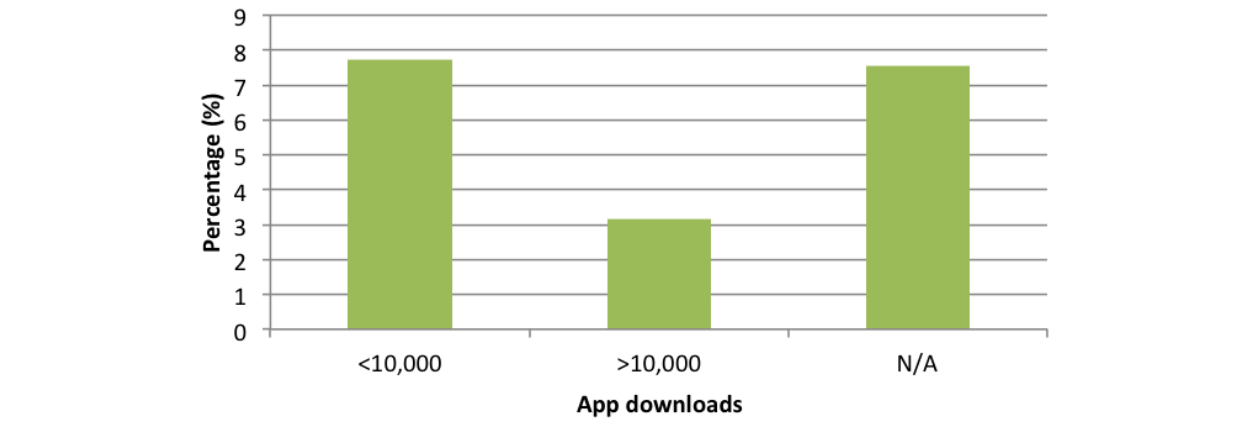
Figure 7. Chart comparing education method percentage according to downloads.